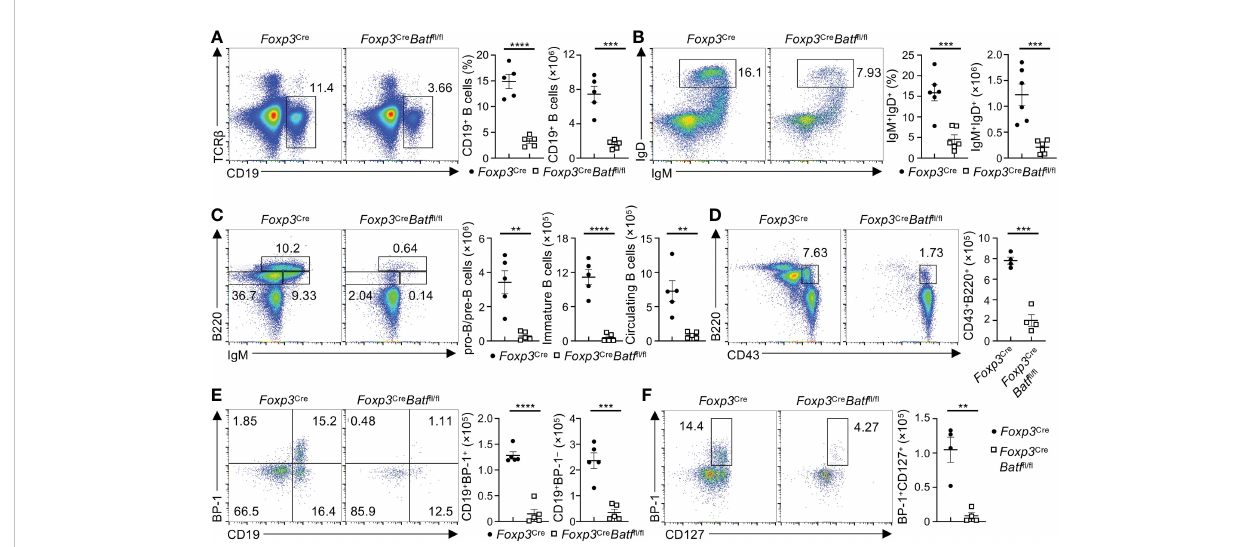
FIGURE 6 Loss of BATF in Tregs leads to the impaired development of B cells. (A) Flow cytometry analysis of CD19 + B cells in the BM from Foxp3 Cre and Foxp3 Cre Batf fl / fl mice. Frequencies (middle) and numbers (right) of CD19 + B cells in the BM ( n = 5 per group). (B) Flow cytometric analysis of IgD + IgM + B cells in the BM from Foxp3 Cre and Foxp3 Cre Batf fl / fl mice. Right, frequencies and numbers of IgM + IgD + B cells ( n = 6 per group). (C) Flow cytometry analysis of B220 and IgM expression in Lin – BM cells from Foxp3 Cre and Foxp3 Cre Batf fl / fl mice. Right, numbers of pro-B/pre-B cells (Lin